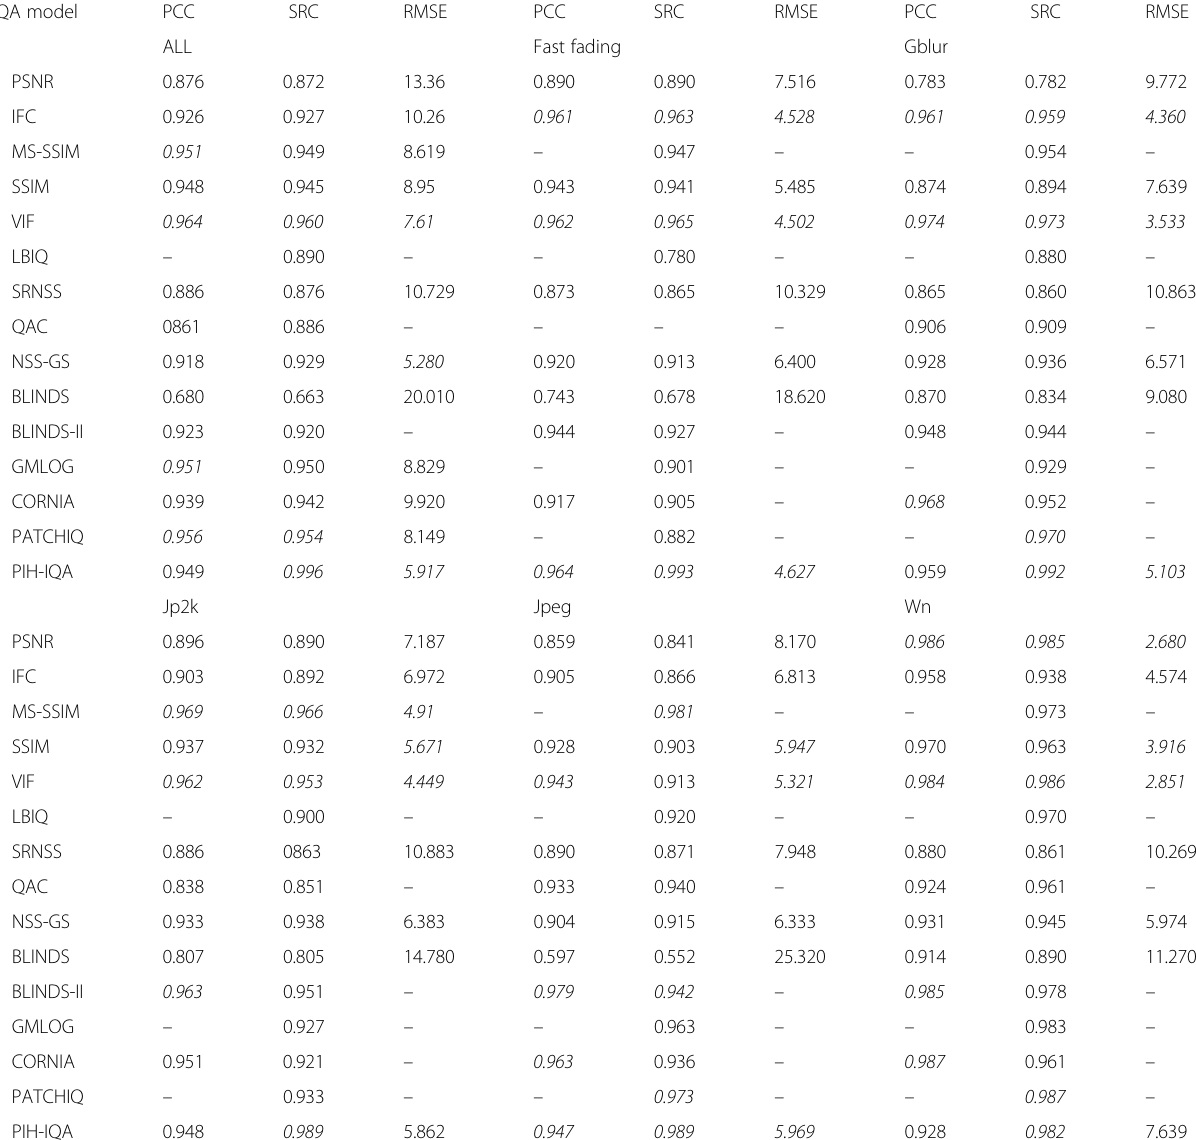
Table 2 Performance comparison of the IQA models on each individual distortion type in the database LIVE 2 IQA